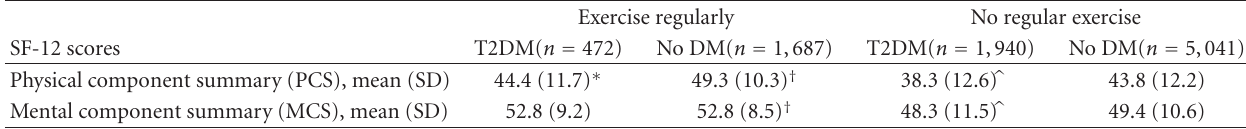
Table 2: SF-12 scores for respondents with and with diabetes who did and did not regularly exercise. Exercise